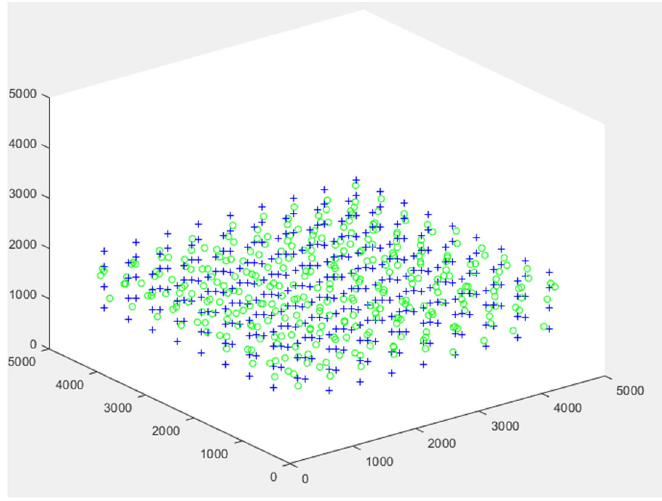
Figure 7. Target position obtained from normal data.